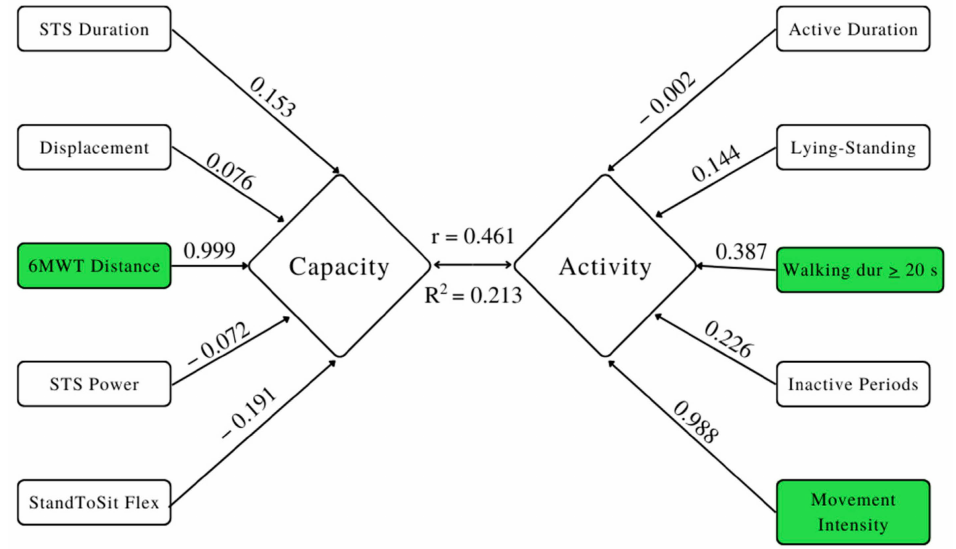
Figure 1. Model depicting the first canonical correlation between capacity and activity showing both the canonical correlation (r) and the amount of variability accounted for by the model (R 2 ). The coefficients/weights for each variable are presented adjacent to their arrow. The significant contributors to the activity-capacity relationship are